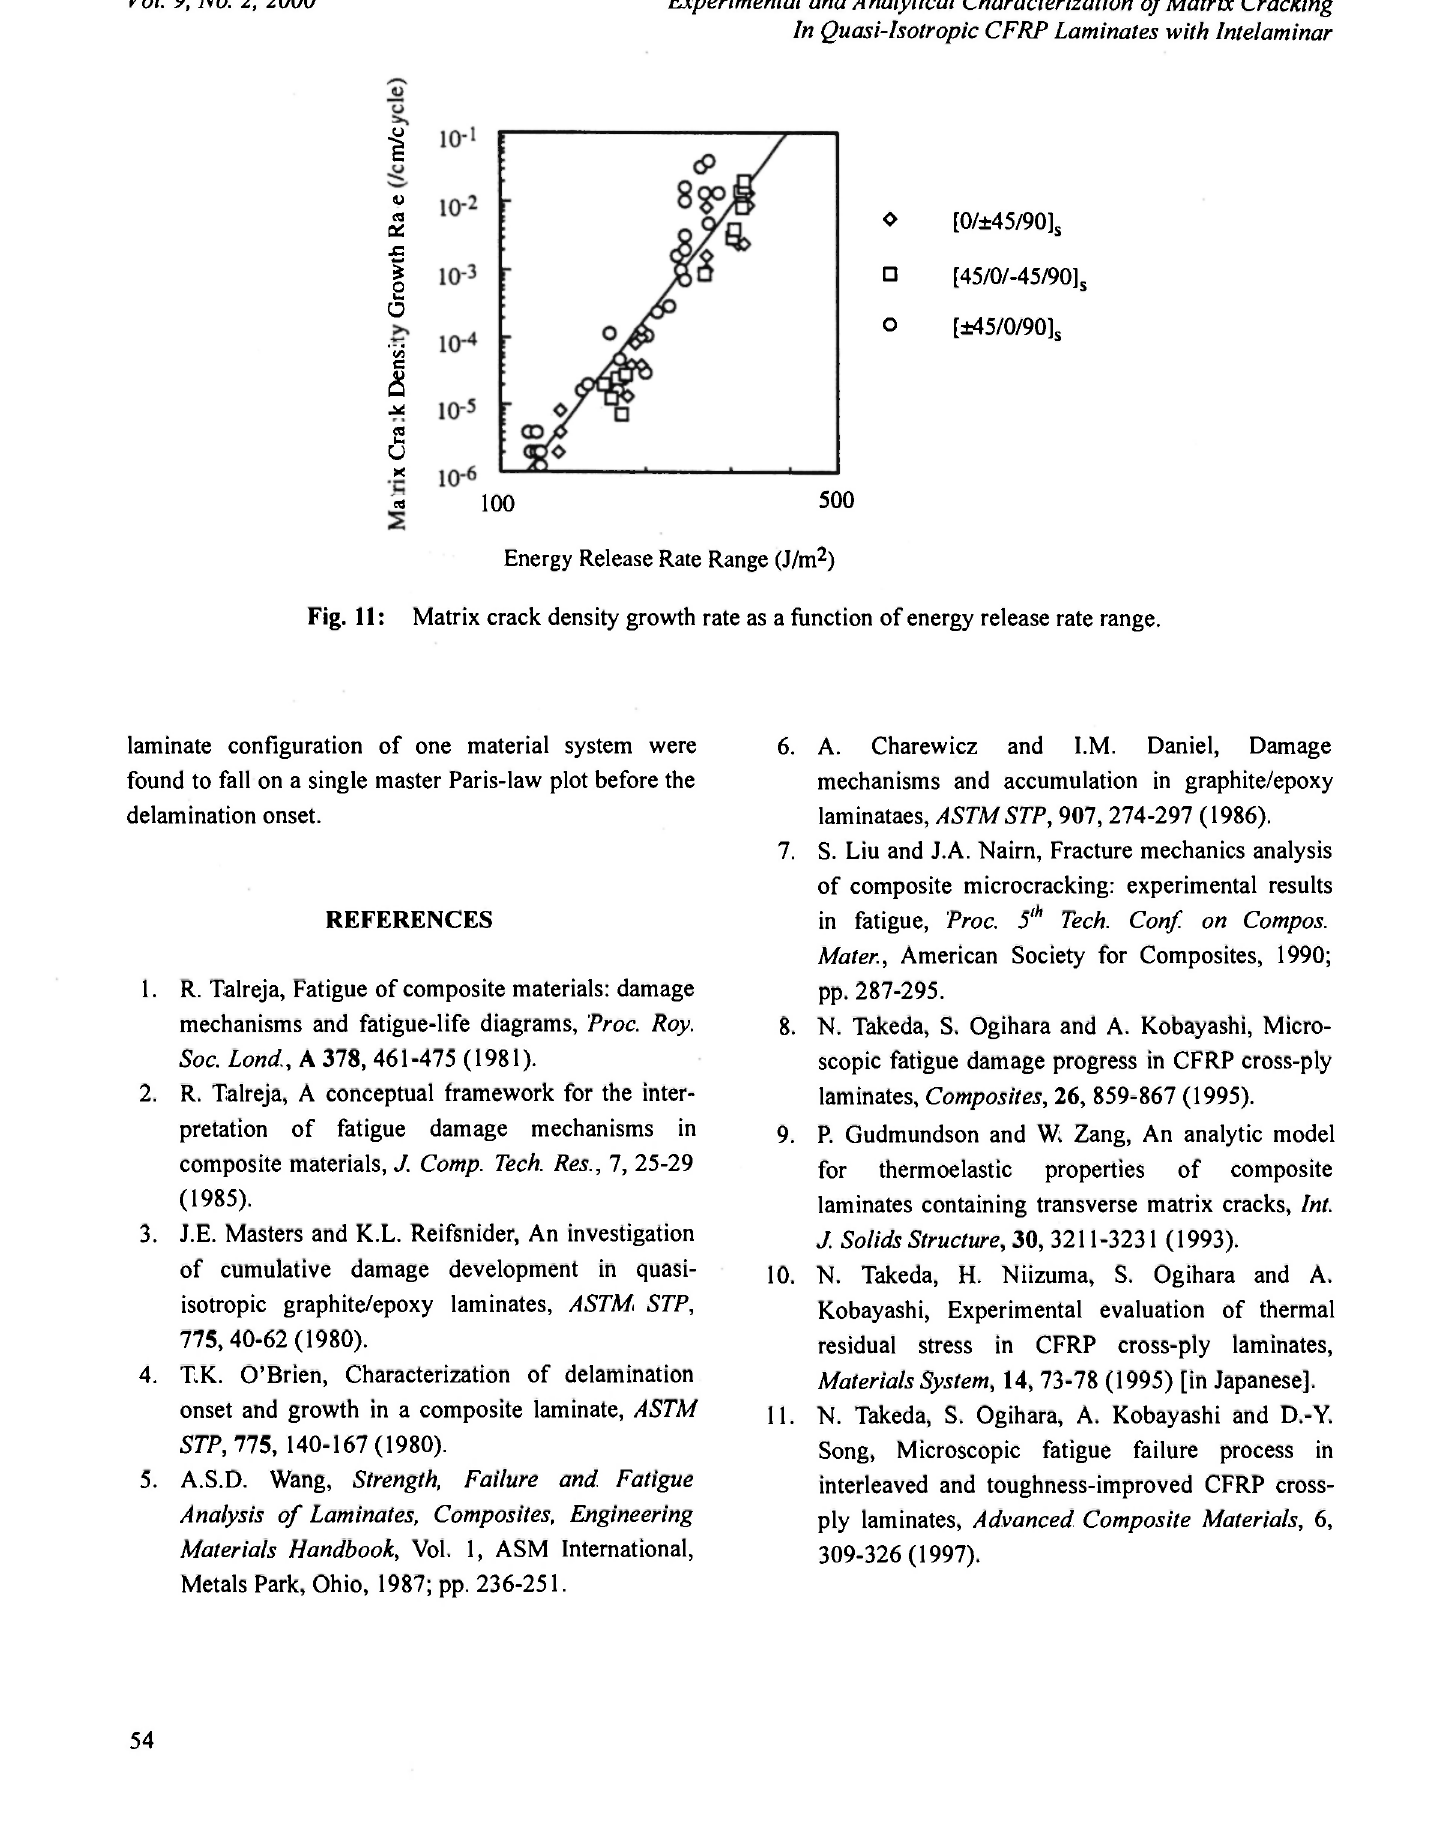
Fig. 11: Matrix crack density growth rate as a function of energy release rate